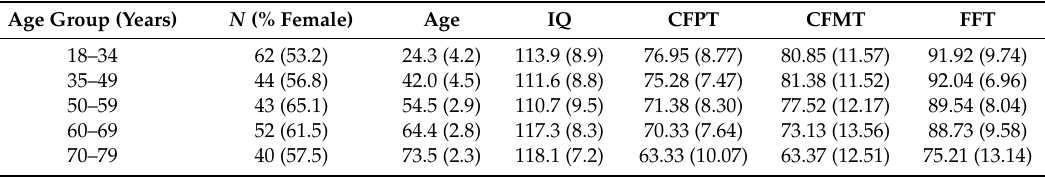
Table 1. Demographic information for control participants from each age group, including mean (SD) age and IQ (measured using the Wechsler test of adult reading (WTAR)). Mean (SD) percentage accuracies for the Cambridge face perception test (CFPT), Cambridge face memory test (CFMT) and famous face test (FFT) are also